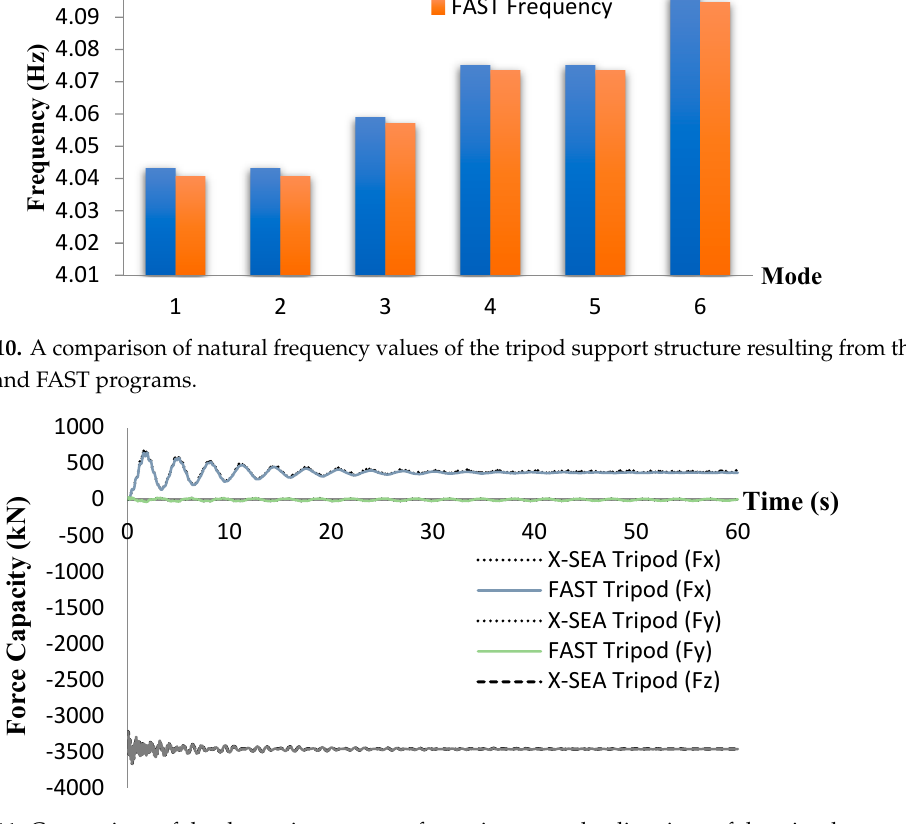
Figure 11. Comparison of the dynamic top-tower forces in x, y, and z directions of the tripod support structure that resulted from the X-SEA and FAST programs.